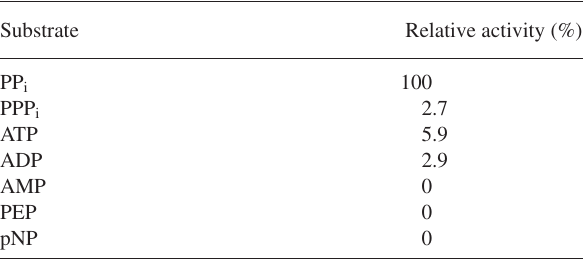
Table 1. Substrate specificity of the Pyroccocus horikoshii pyrophos- phatase ( Ph PPase). Activities were determined as described in Mate- rials and methods. Each substrate was tested at a concentration of 1 mM in the presence of 5 mM Mg 2+ .